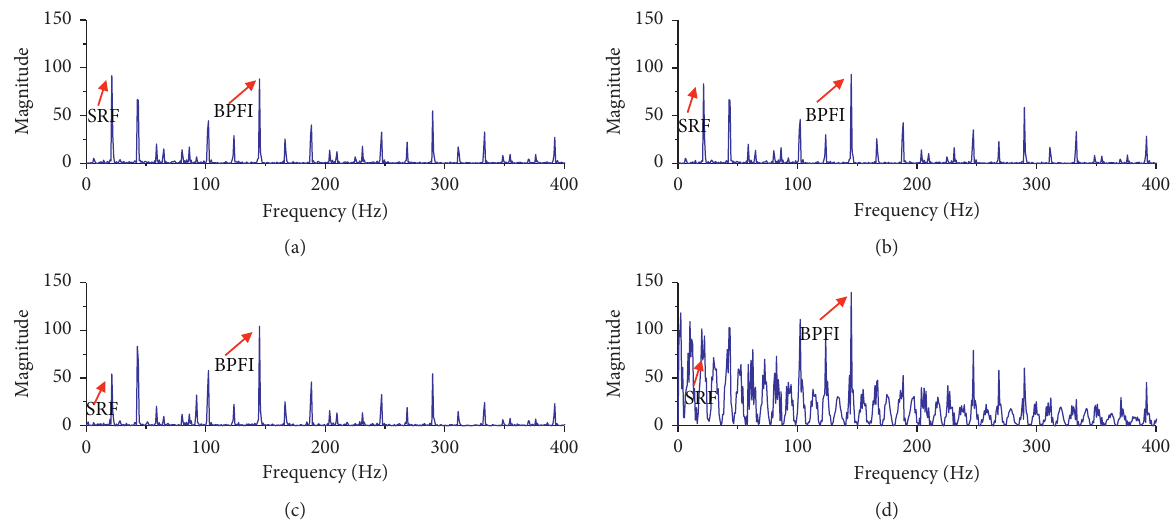
Figure 10: Processing result of the vibration signal induced by the inner race fault. (a) Envelope demodulation; (b) peak-based wavelet decomposition; (c) parameter-optimized peak-based wavelet decomposition; (d) proposed peak-based mode decomposition.